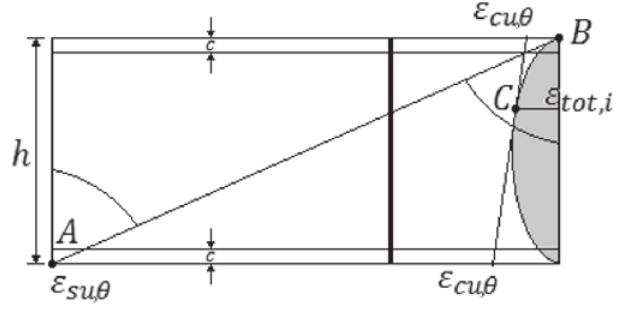
ε : Deformação específica linear convencionalmente correspon - cu dente ao estado limite ultimo de ruptura da fibra mais comprimida de concreto, de uma seção transversal totalmente comprimida. ε : Deformação específica linear convencionalmente correspon - c2 dente ao estado limite ultimo de ruptura da fibra menos comprimi - da de concreto, de uma seção transversal totalmente comprimida. ε : Deformação específica linear convencionalmente correspon - su dente ao estado limite ultimo de ruptura da armadura tracionada. ε : Deformação específica linear correspondente ao início do es - yd coamento da armadura tracionada. h: Altura da seção transversal.